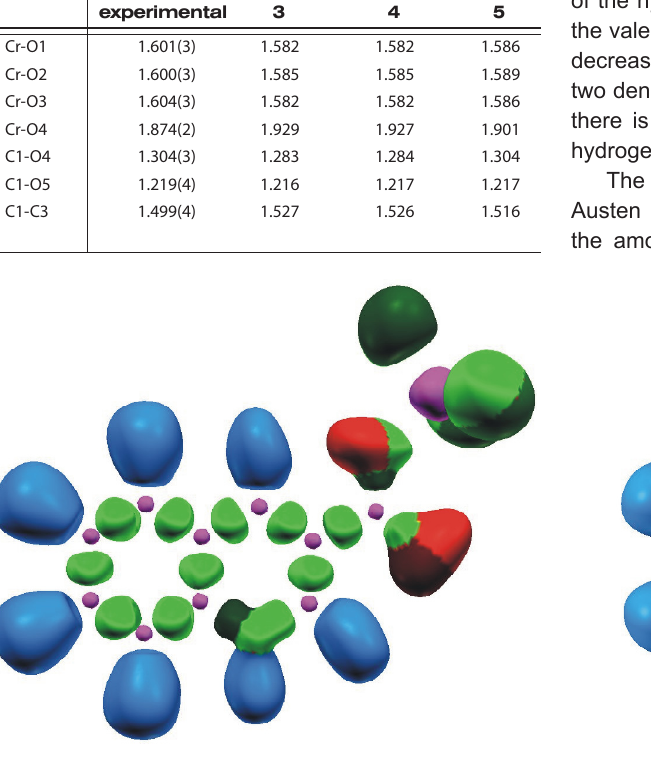
Table 2. Selected geometrical parameters for the experimental structure and for optimized structures 3 -5 at the B3LYP/6-311G* level. experimental